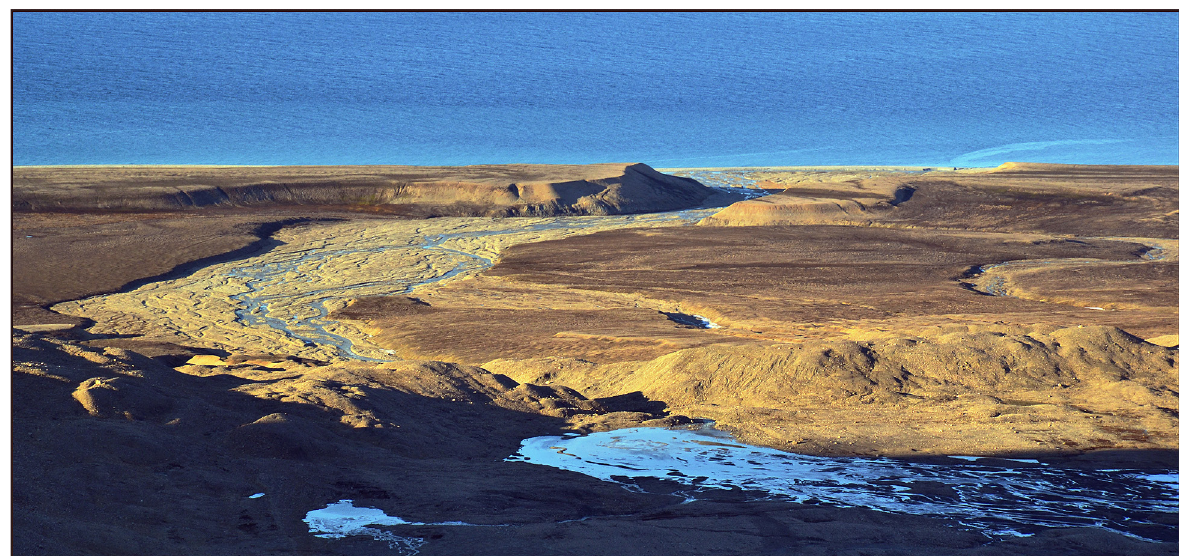
Fig. 2. downstream view of the central and lower part of the Scott River valley with variable channel